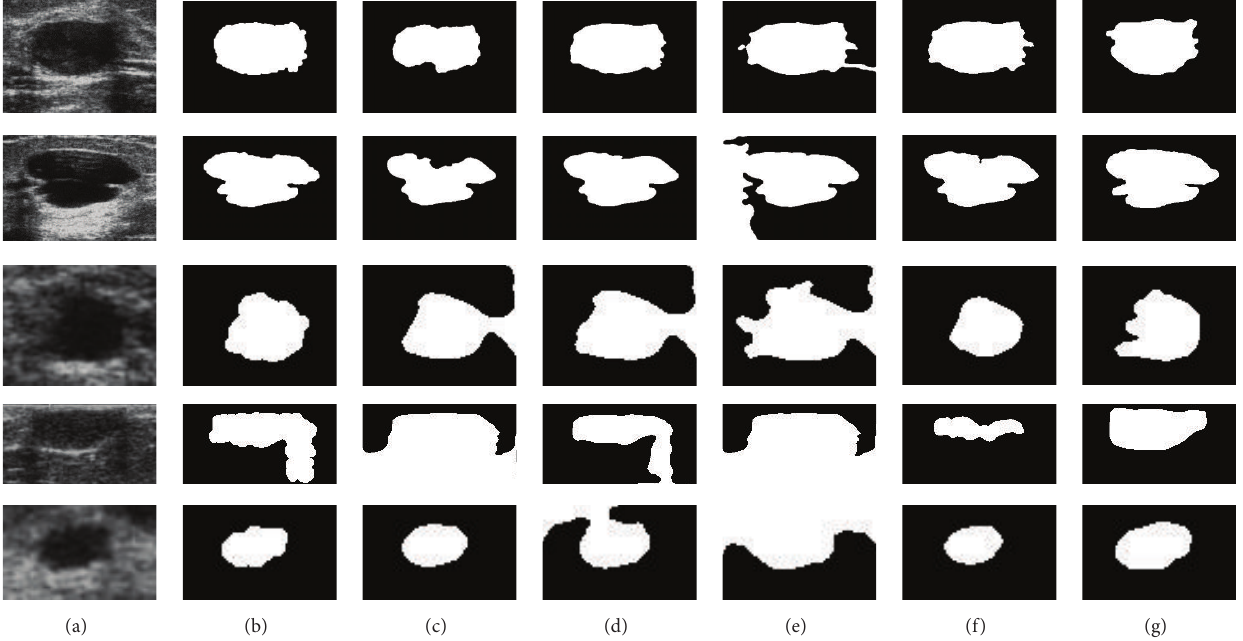
Figure 8: Results from tests with actual images: (a) original ROI; segmentations by (b) active contour, (c) region growing, (d) fuzzy 𝑐 -means, (e) 𝑘 -means, (f) SOM, and (g) delineation by the